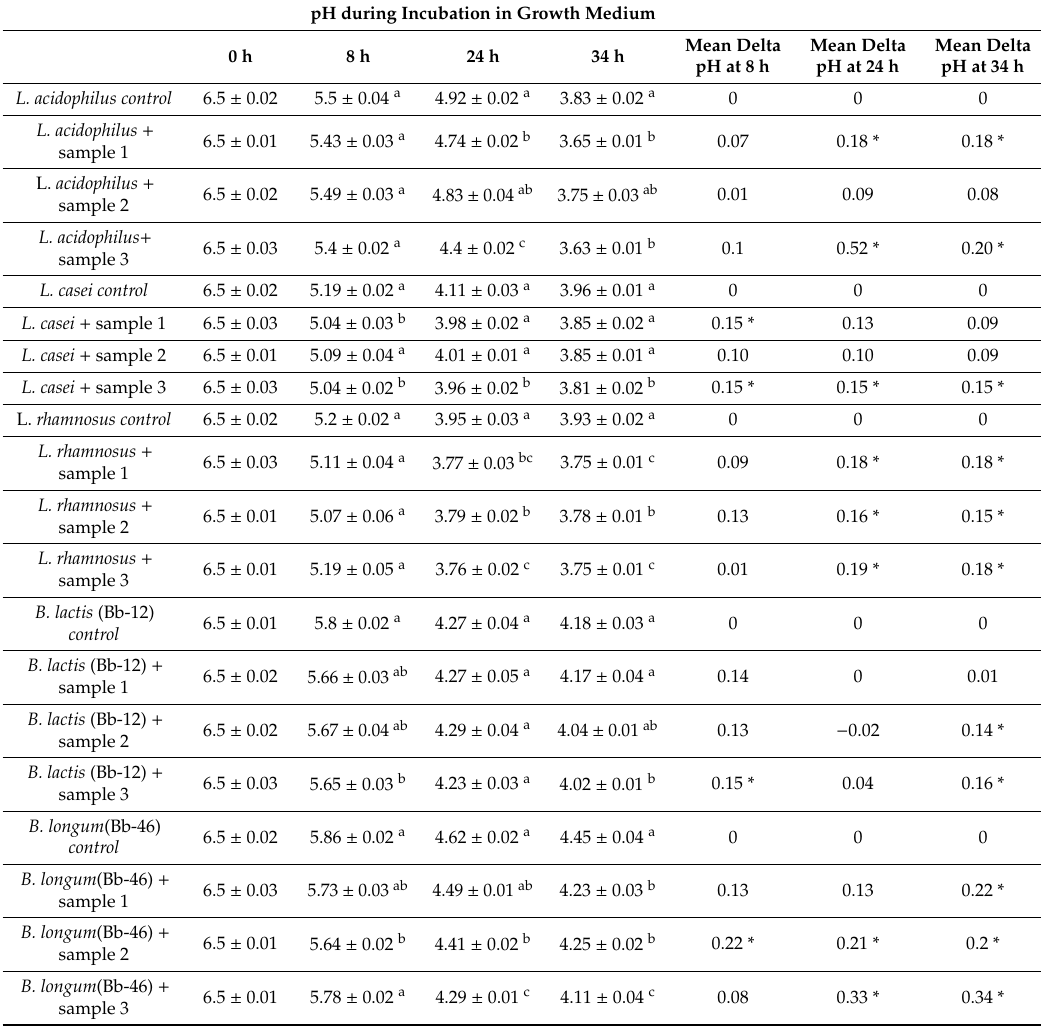
Table 2. The pH evolution of synthetic growth medium inoculated with probiotic bacteria, without (control) or with the addition of encapsulated Goji berry extracts (samples